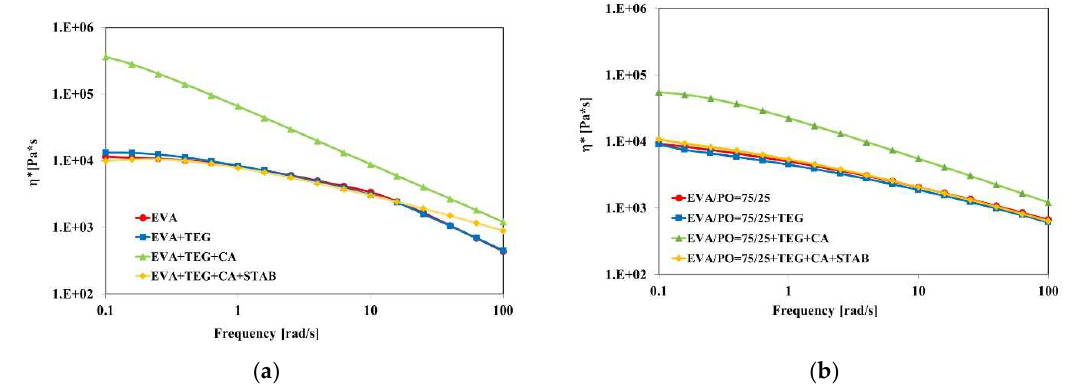
Figure 3. Viscosity curves of the ( a ) EVA and ( b ) EVA/PO = 75/25 wt.% samples with and